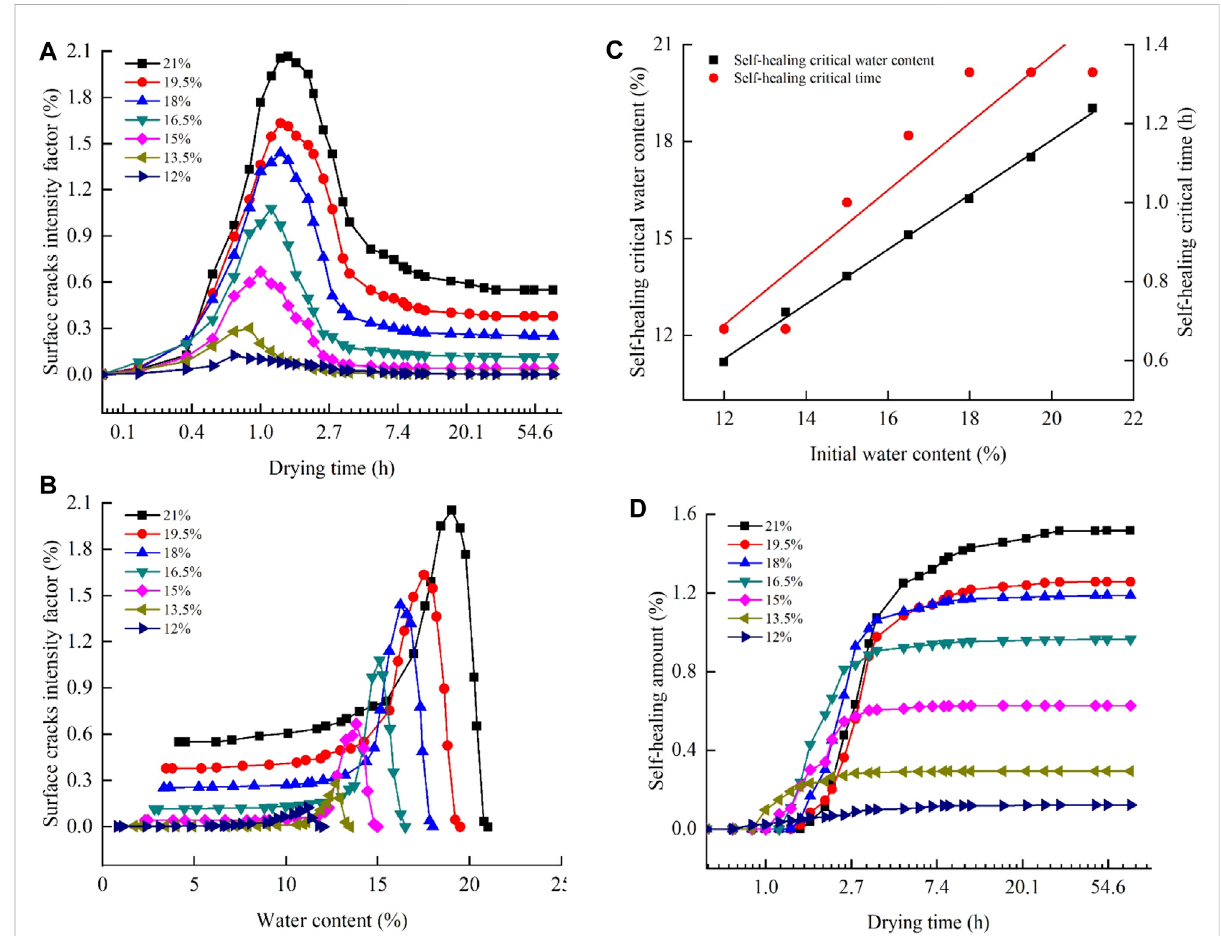
FIGURE 10 Evolution of crack ratio for specimens with different initial water content during drying (A) Variation of SCIF with time, (B) Variation of SCIF with water content, (C) Variation of critical self healing conditions, and (D) Variation of self healing amount with